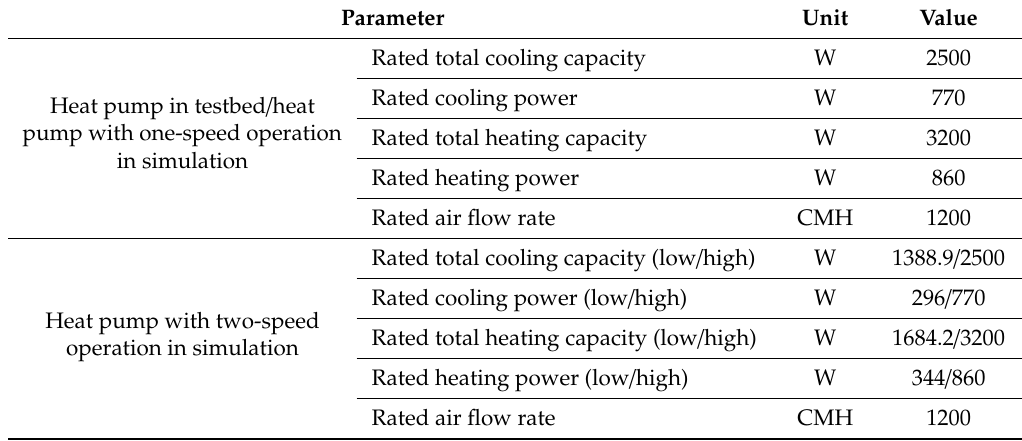
Table 5. Heat-pump specifications installed in the testbed / applied to the